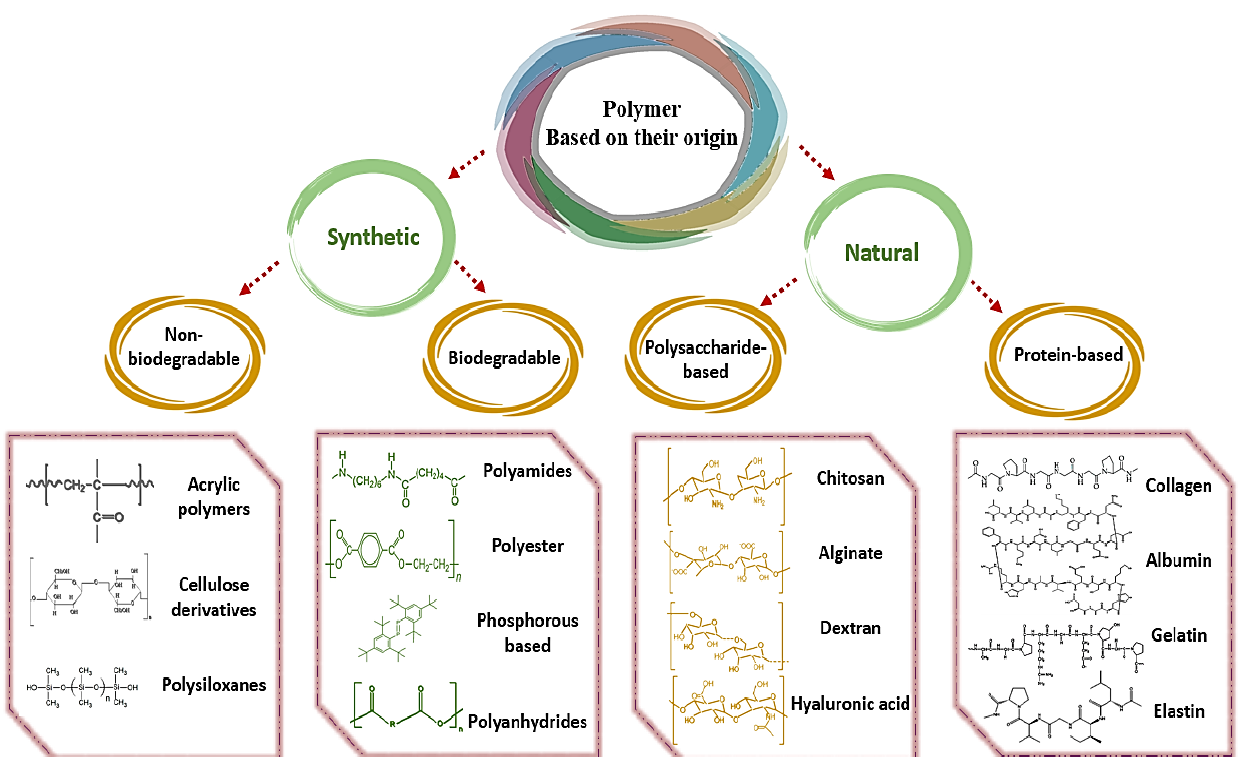
Figure 1. Classification of polymers-based on their origin.